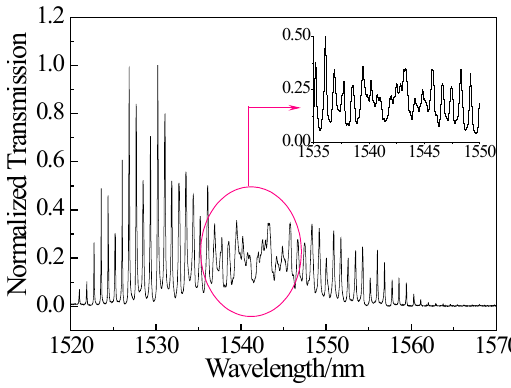
Figure 8. Resonance spectrum of drop port in